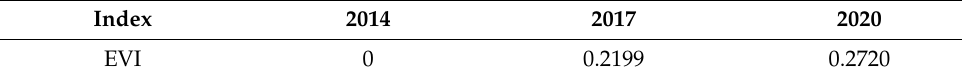
Table 6. Results of forest landscape EVI